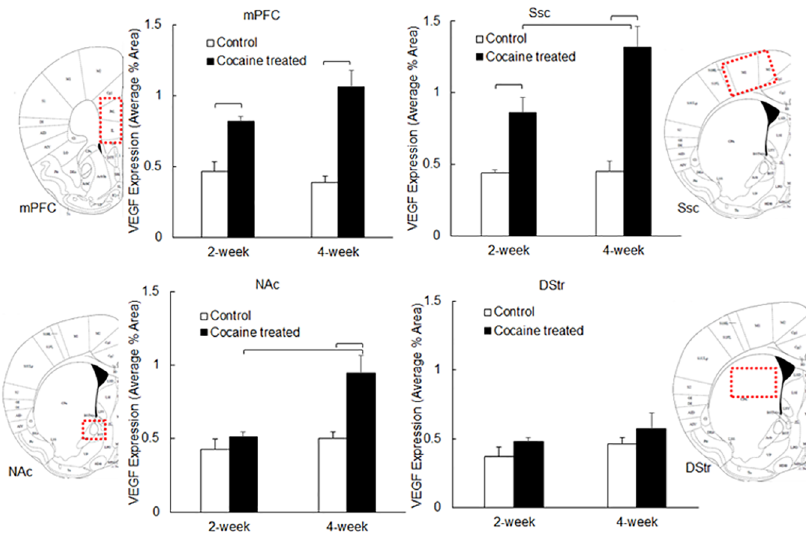
Fig 4. VEGF expressionin rat brain tissue measuredusing immunofluorescencemicroscopy. Data is presented as mean + standarderror (n = 3–4). ANOVA was used to detect significantdifference between treatment groups. Significantdifferences ( P < 0.05)are marked.